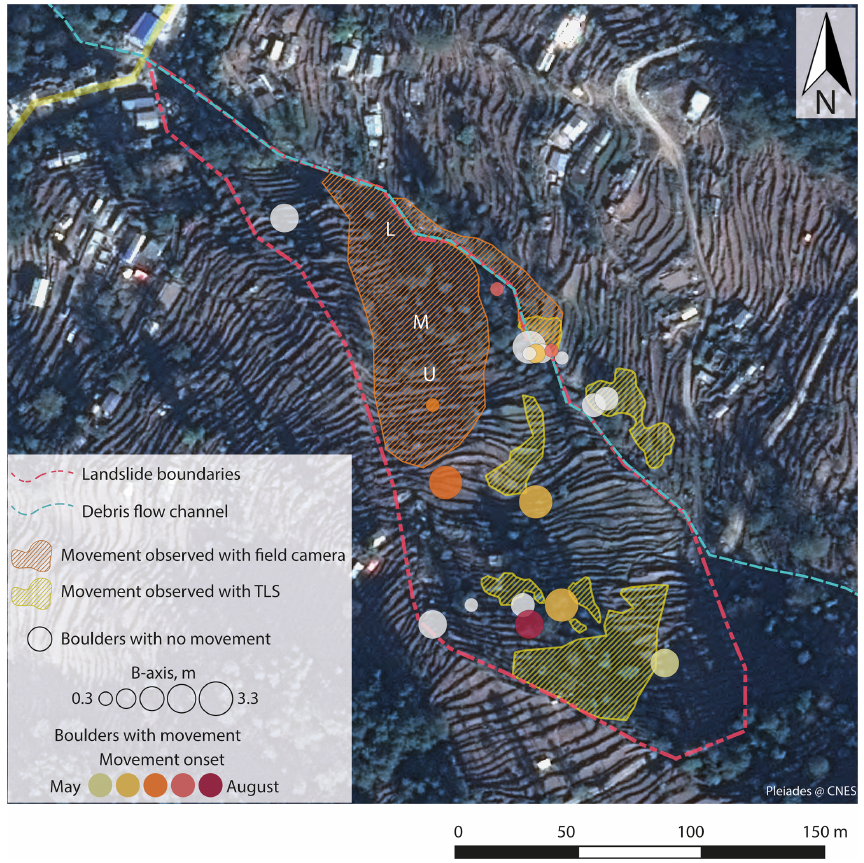
Figure 4. Zoom of two tagged sites. The sizes are scaled according to the b axis of the boulders (an example of scales is given for boulders without movement in the legend, but it applies to all boulders). White squares are boulders that did not move or for which movement was not recorded. Green circles are boulders in the debris flow channel. Yellow to red symbols are boulders within the landslide body. Hatched areas are zones with observed movement through images (L: lower, M: mid-slope, U: upper) and terrestrial laser scanning. Image: Pleiades (CEOS Landslides